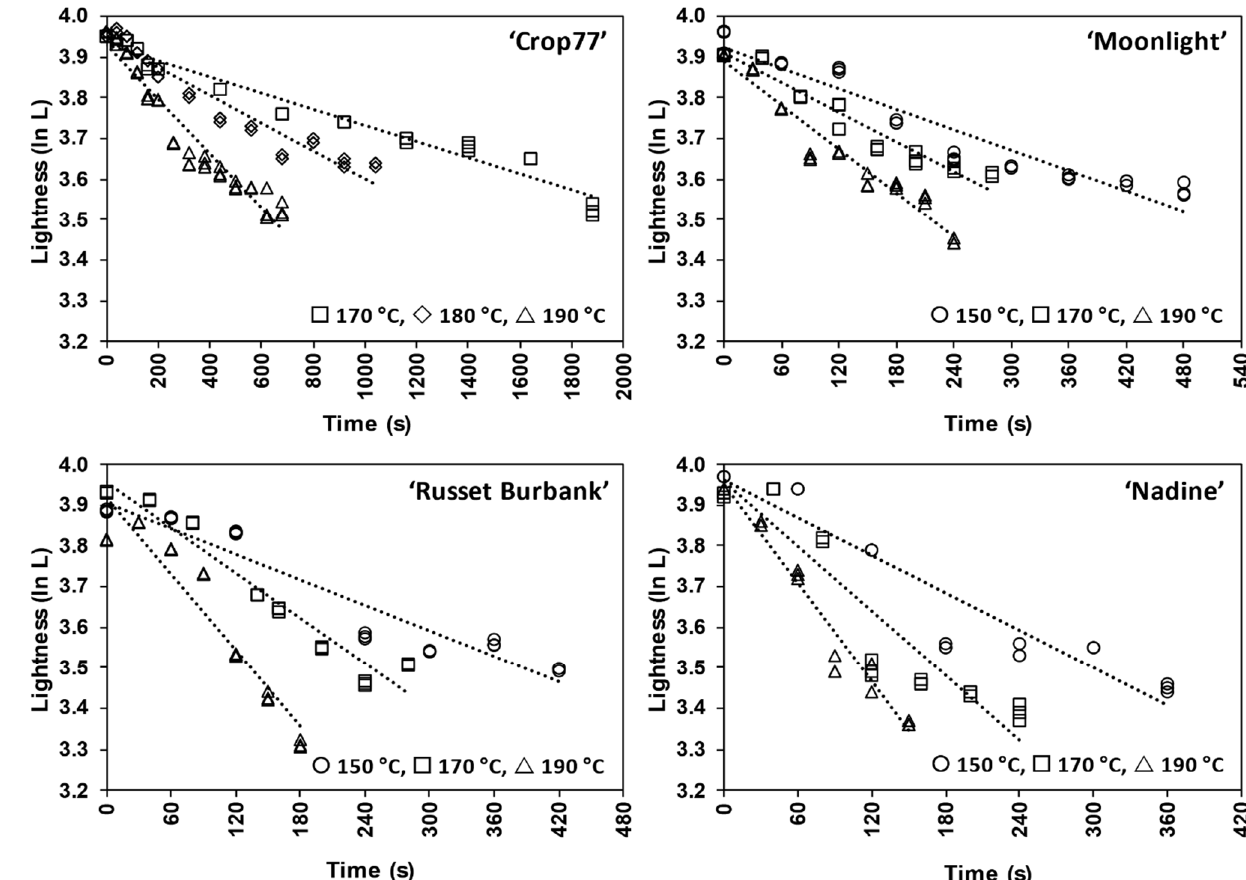
Figure 1. An example of fitting the first-order kinetic model to the experimental lightness data (natural logarithm of L * values against frying time) at different frying temperatures for ‘Crop77’, ‘Moonlight’, ‘Nadine’ and ‘Russet Burbank’ subjected to blanching treatment only. Symbols represent the experimental lightness data (average measurements from three independent frying experiments per frying time point where each experiment involved a batch of 8–10 potatoes) and the predicted lightness values from the first-order reaction (Equation (3)) are represented by the continuous dots. The L * of potato slices prior to frying was averaged at 57.15 ± 1.33, 57.09 ± 1.48, 54.60 ± 2.17 and 52.76 ± 1.49 respectively for ‘Crop77’, ‘Moonlight’, ‘Nadine’ and ‘Russet Burbank’.